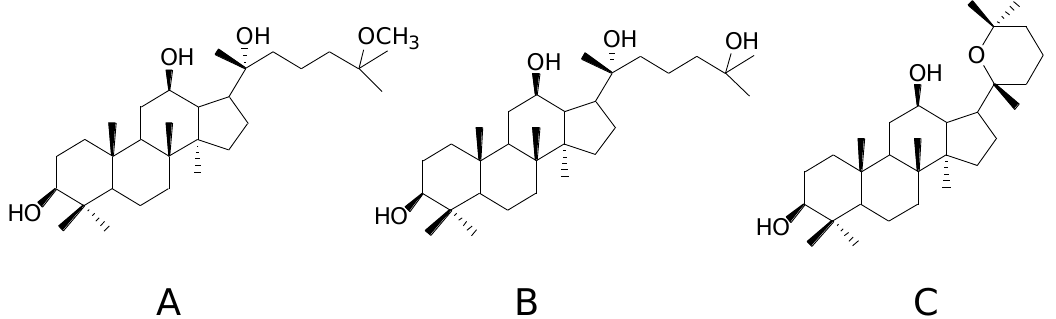
Figure 1. ( A )The structure of 25-methoxyprotopanaxadiol (25-OCH 3 -PPD, AD-1); ( B ) the structureof 25-hydroxyprotopanaxadiol (25-OH-PPD, AD-2); ( C ) the structure of panaxadiol (PD).